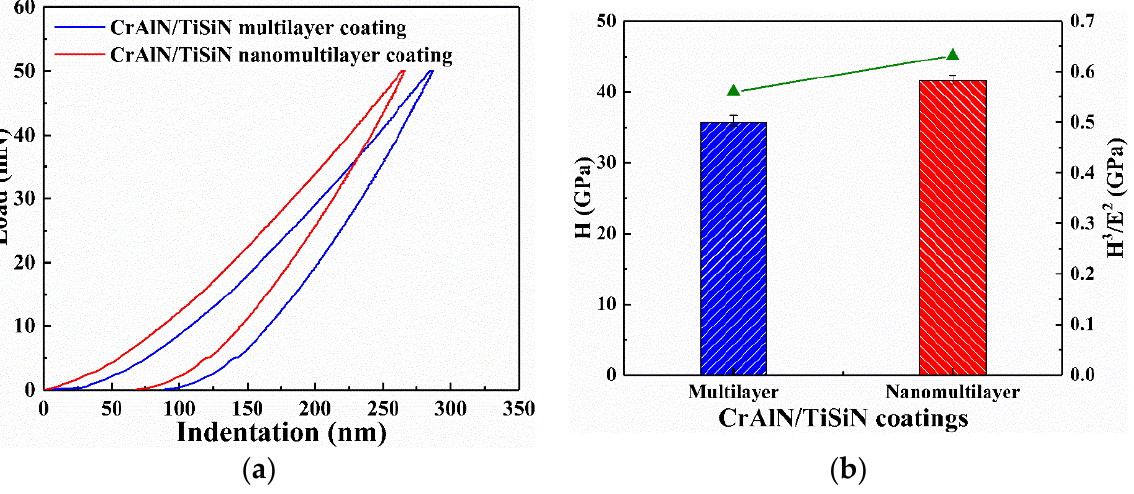
Figure 6. Indentation results of two CrAlN/TiSiN coatings. ( a ) Indentation–load curves; ( b ) Nanohardness and plasticity index.